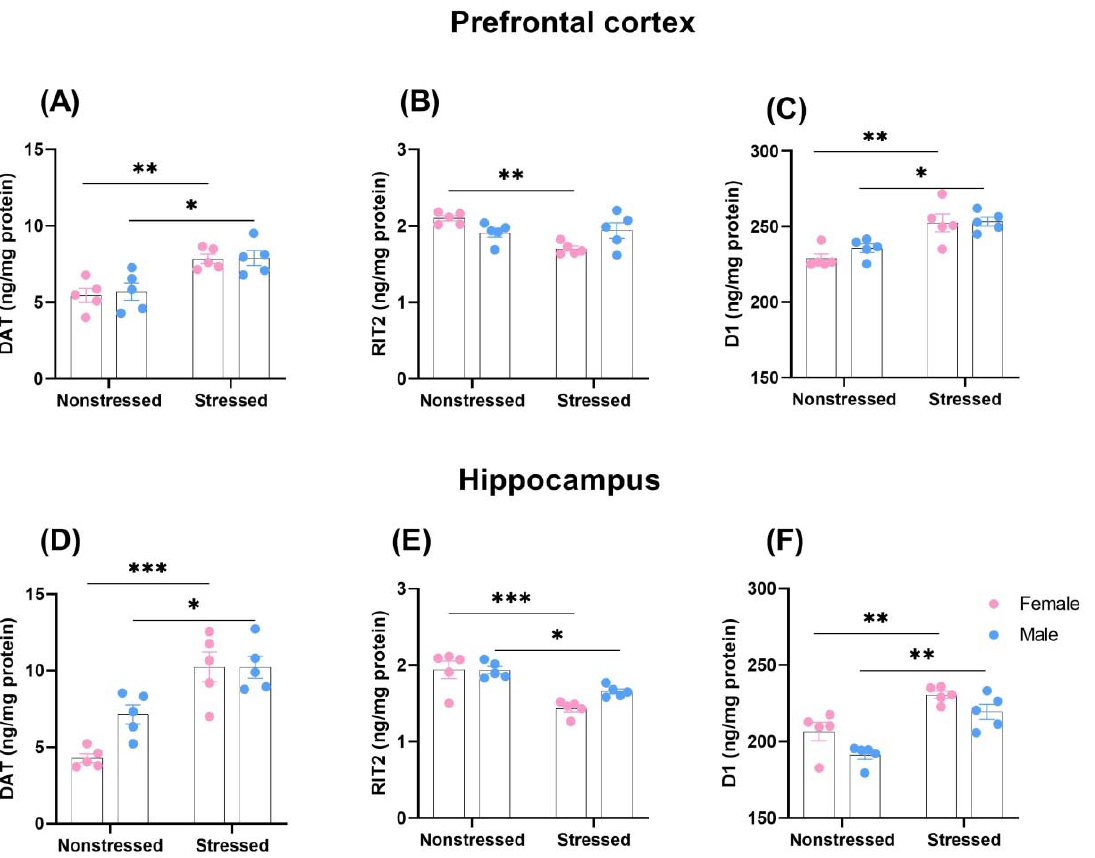
Figure 3. Effect of MS on dopamine transporter (DAT; ( A , D )), GTP-binding protein RIT2 ( B , E ), and D1 receptor expression ( C , F ) in the prefrontal cortex and hippocampus in adolescent (PND34) male and female rats. Data represent mean ± SEM (N = 5 rats/group). The concentration of proteins was calculated from a standard curve and expressed as ng/mg of protein. * p < 0.05; ** p < 0.01; *** p < 0.01 vs. Nonstressed.